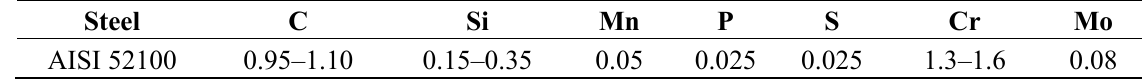
Table A2. Chemical composition (wt. %) of AISI 52100 ball.